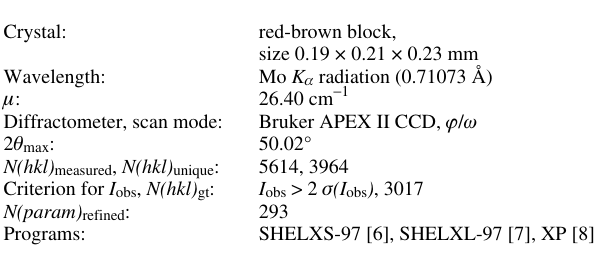
Table 1. Data collection and handling.